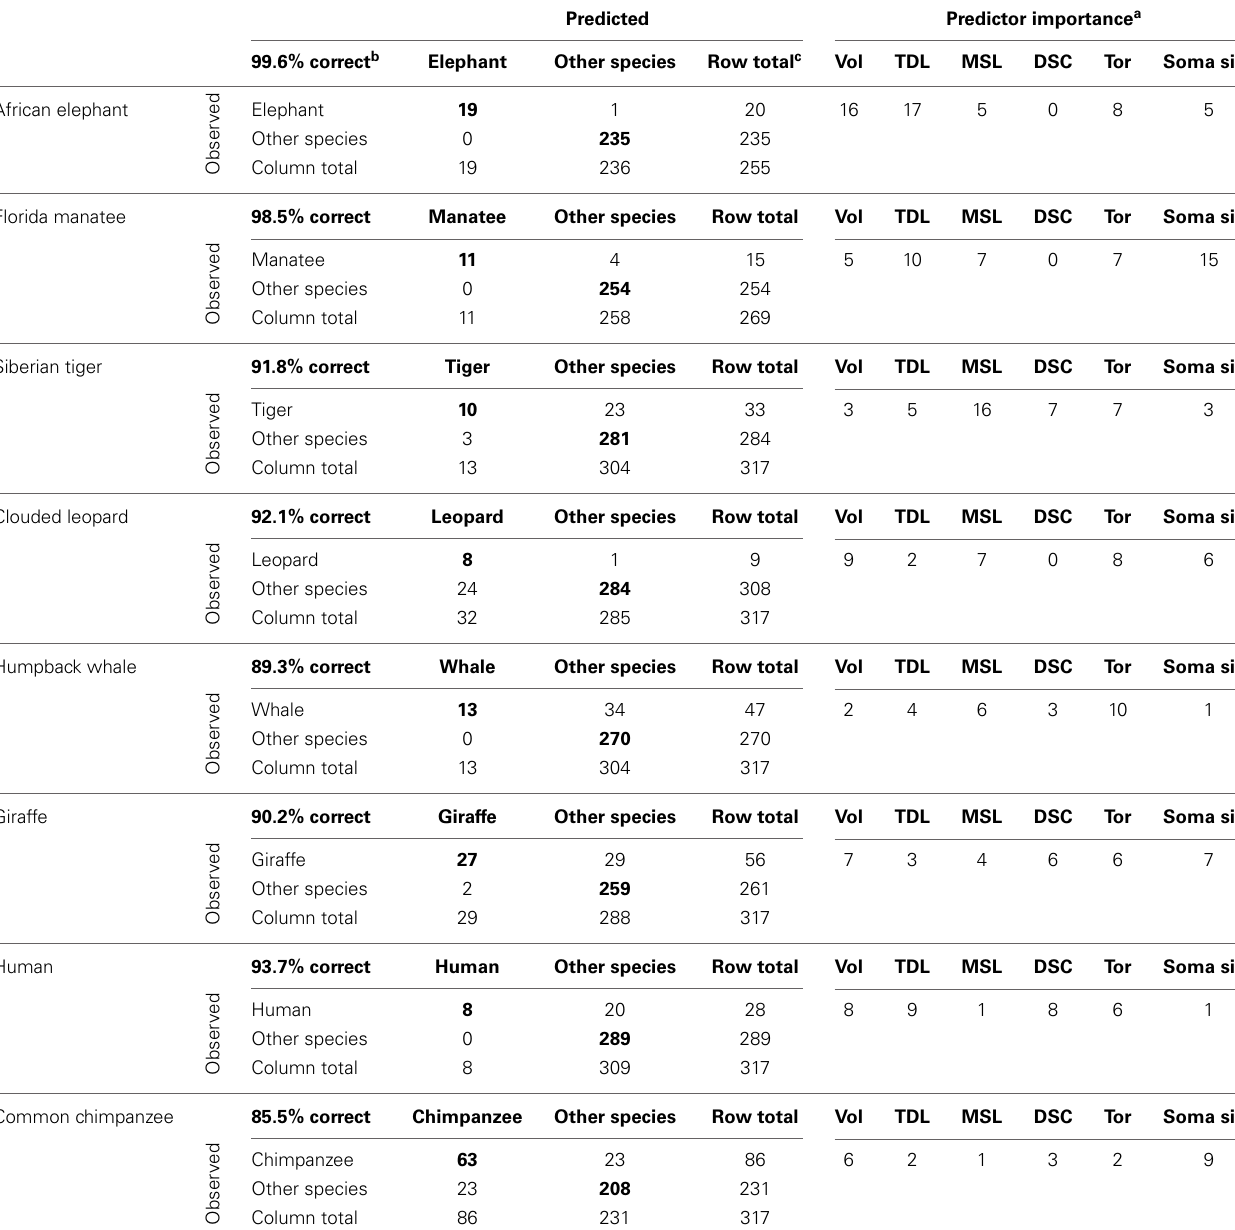
Table 4 | Correct-incorrect confusion matrices for differentiation of